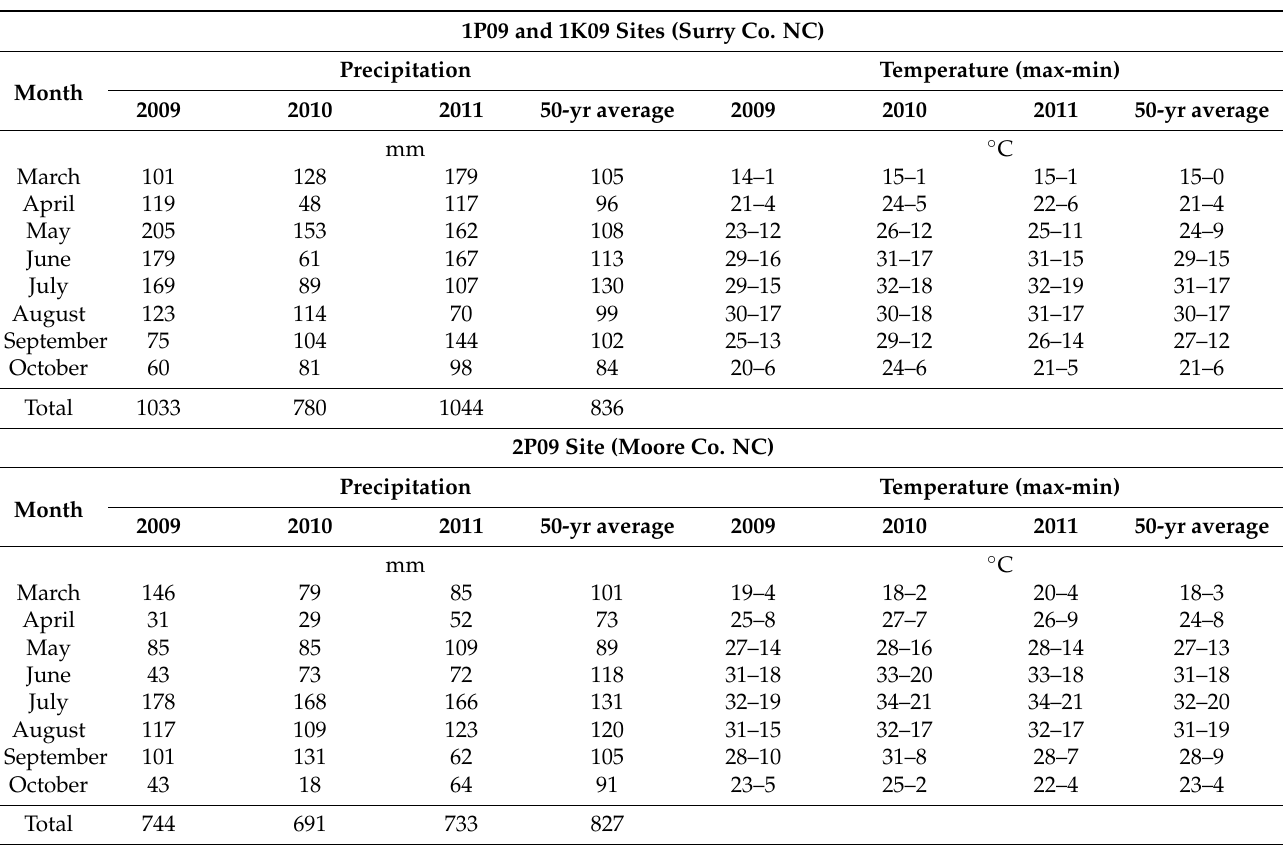
Table 7. Growing season rainfall and temperature at P and K (2008–2011). 1P09 and 1K09 Sites (Surry Co.